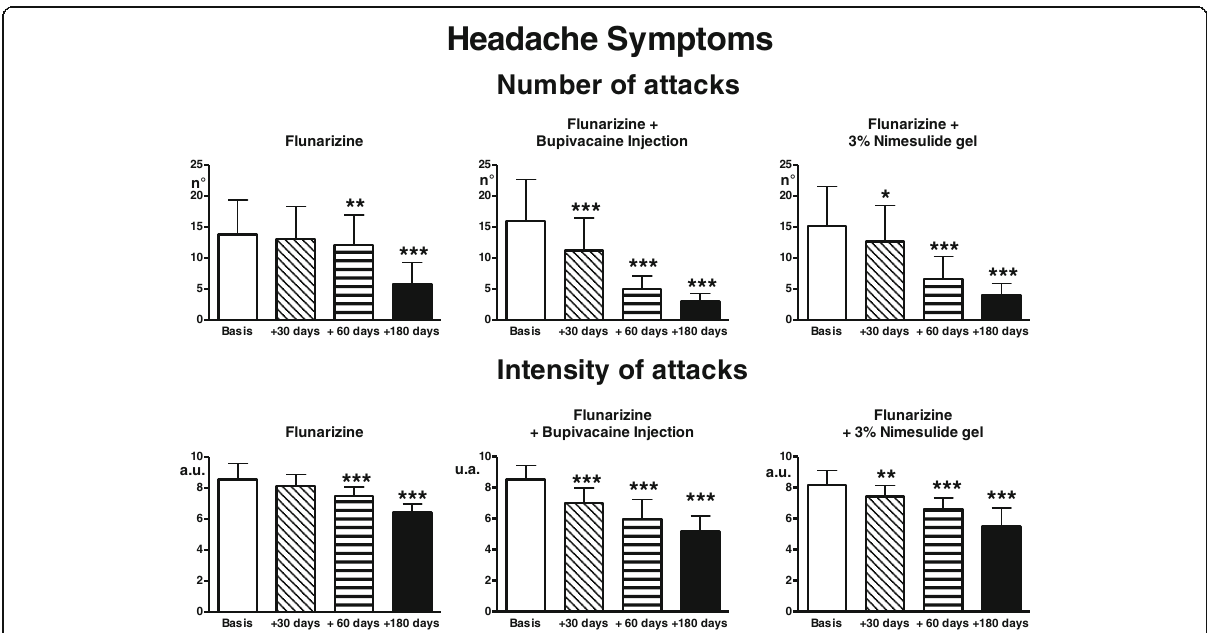
Fig. 1 Mean monthly number of migraine attacks and their intensity recorded on the headache diary in the 3 treatment groups (flunarizine; flunarizine + bupivacaine injection of the TrP, flunarizine + 3% nimesulide gel application over the TrP)(n. 25 patients each, Means ± SD) in basal conditions (1 month preceding start of treatment) and 30, 60 and 180 days from start of treatment. * = p < 0.05; ** = p < 0.01; *** = p < 0.001: comparison of treatment and post-treatment evaluations with basal